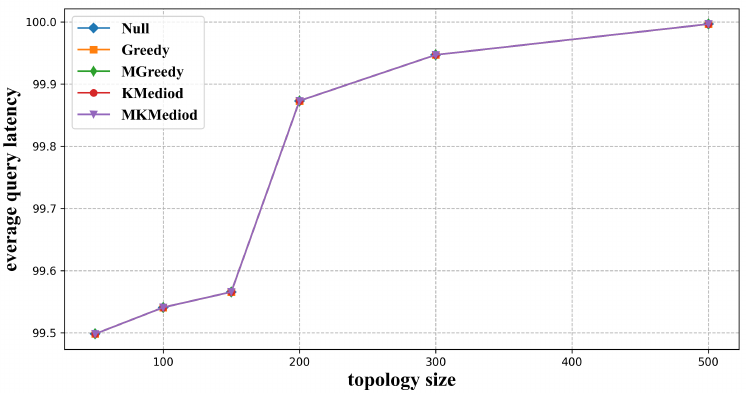
Figure 9. Maximum resolution latency of each algorithm with different network